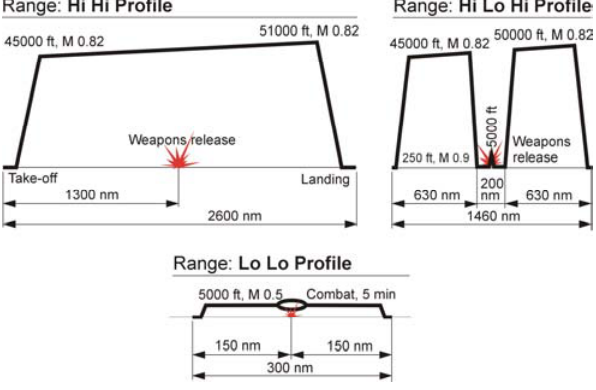
Fig 1. Typical UCAV missions – scenario of offensive flight UCAVs can be used in many combat missions. A typical mission is the weapon release, which can be realized from either from high (the so-called Hi_Hi_profile) or low (the so-called Hi_Low_Hi_profile) altitude. The PW-124 aircraf, because of its limited weight and range, can perform the so-called Lo_Lo_mission, Fig. 1. Such a mission is shown at Fig. 2. Aircraft ascends to 1500 m, flies approximately 200 km with the speed corresponding to the best specific range, then descends to 200 m, manoeuvres during a 5- min time period at full thrust, then ascends again to 1500 m and returns back to base. Of course, the horizontal flight altitude and the height of manoeuvring depend on local conditions and can be slightly changed with respect to the mission of Fig. 2, if necessary.